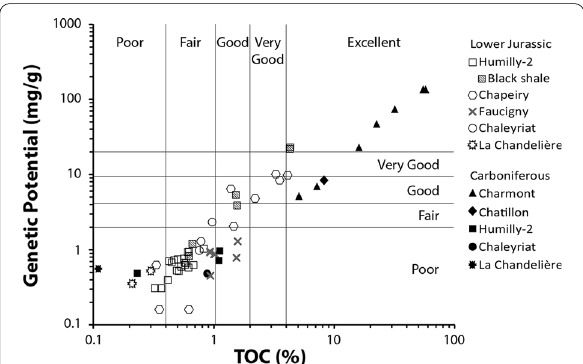
Fig. 11 Petroleum generation potential (S1 (classification after Peters and Cassa